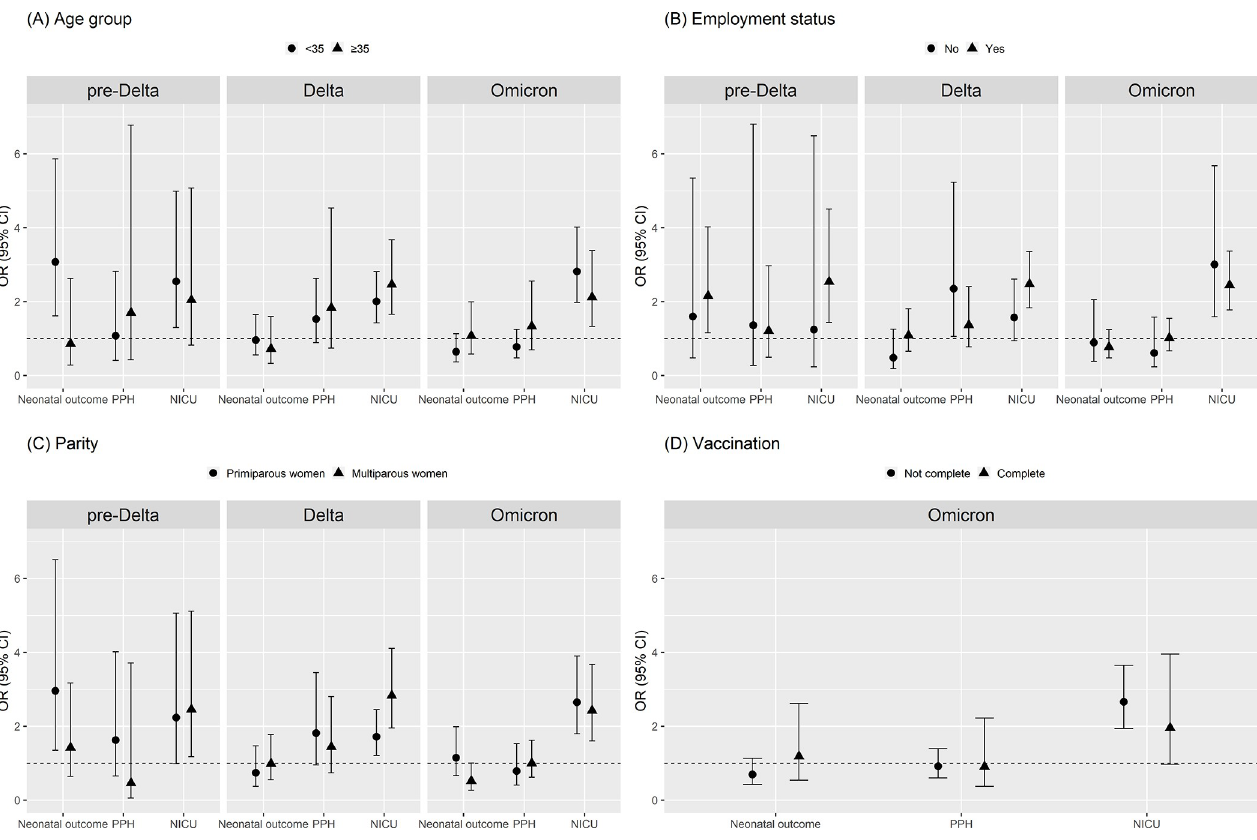
Fig 4. Subgroup analysis of association of COVID-19 infection during pregnancy with adverse outcomes (neonatal outcome, postpartum hemorrhage, and admission to NICU) using 1:4 propensity score matching. Abbreviations: CI, confidence intervals; OR, odds ratio; NICU: neonatal intensive care unit.